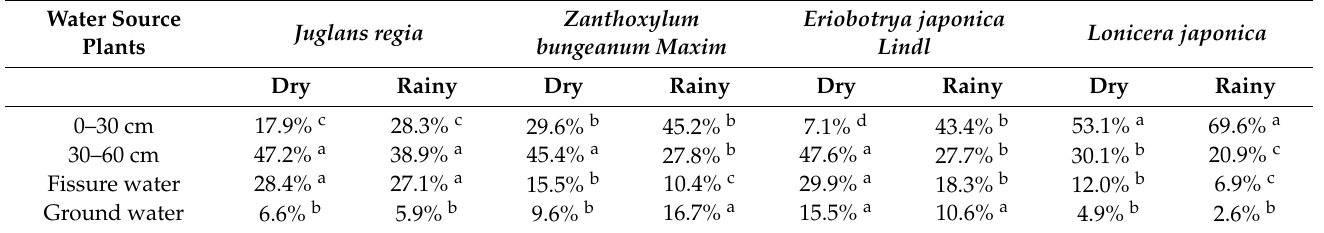
Table 2. Changes in water use ratio of four species in dry rainy season.